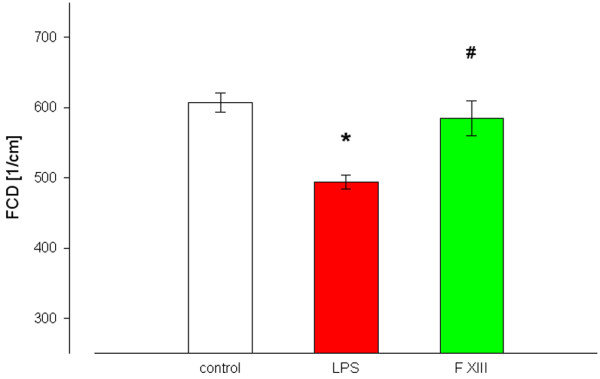
Effects of factor XIII administration on intestinal functional capillary density (FCD) in the mucosal layer during experimental endotoxemia. FCD after one hour of endotoxemia (mean ± standard error of the mean; *p < 0.05 compared to baseline; #p < 0.05 compared to lipopolysaccharide (LPS) group). Control, control group, F XIII, factor XIII treated LPS group; LPS, untreated LPS group.